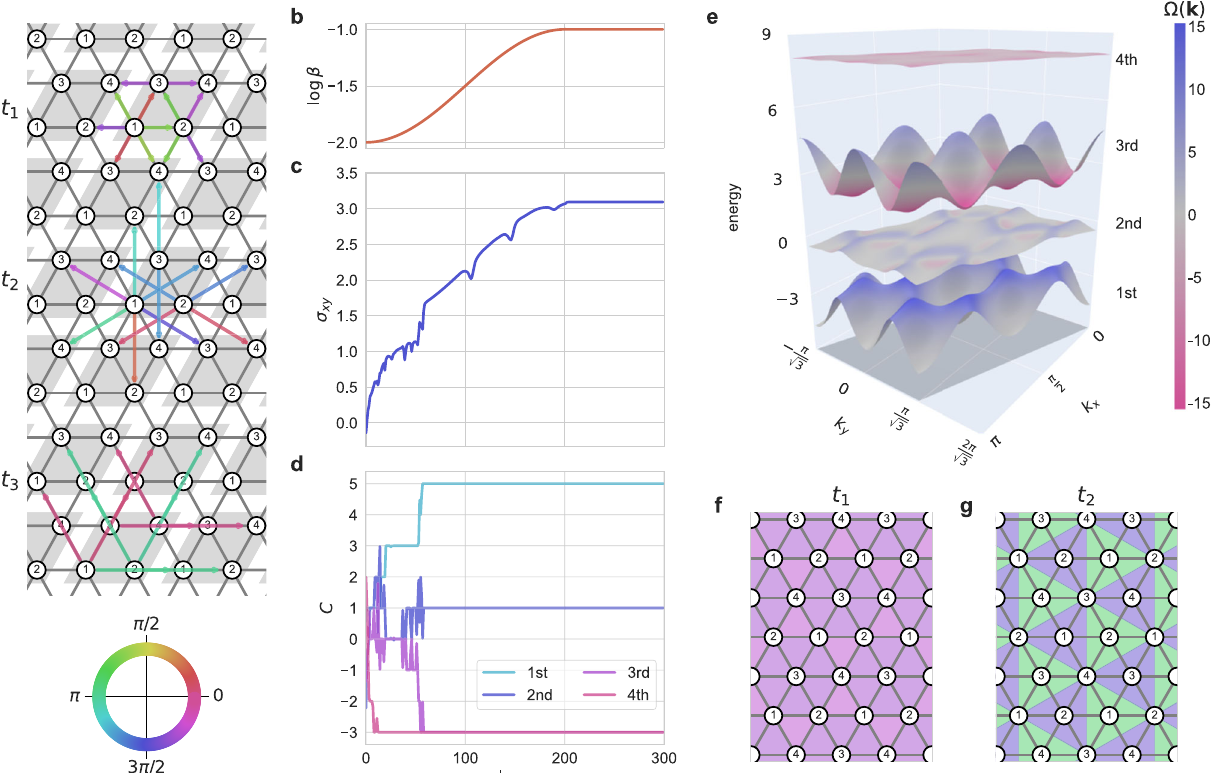
Fig. 3 Automatic construction of a Hamiltonian showing a six-times larger quantum anomalous Hall effect than the Haldane model. a A tight-binding model on a triangular lattice with 38 parameters, including the nearest-neighbor ( t 1 ), the second-neighbor ( t 2 ) and the third-neighbor ( t 3 ) hoppings. The shades denote four-sublattice unit cells. The color of the arrows represents the optimum phase of each hopping, ϕ ij m , after the convergence, according to the inset below. b Schedule of log β , where β is the inverse temperature. c , d Changes of the Hall conductivity σ xy ( c ) and the Chern number C for four bands ( d ). e The band structure after the convergence plotted with the Berry curvature Ω ( k ) at each wavenumber k = ( k x , k y ). f and g Fictitious magnetic fl uxes de fi ned by the sum of phases along the counter-clockwise direction as Φ m ¼ ∑ ij ϕ ij m on the smallest triangles by the nearest-neighbor hopping t 1 ( f ) and larger ones by the second-neighbor hopping t 2 ( g ), which are indicated by the same color code as the inset of ( a